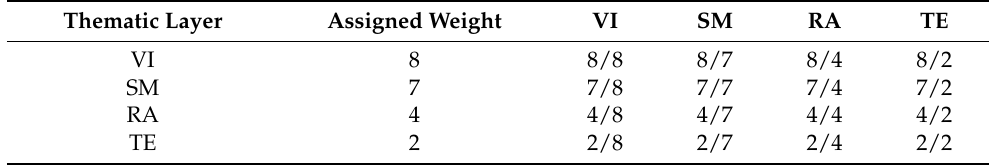
Table 1. Pairwise comparison matrix for the variable layers. Thematic